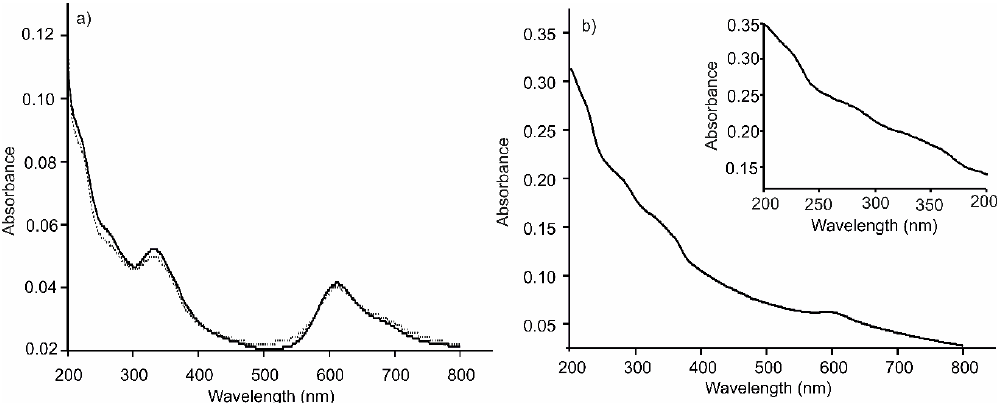
Figure 1. UV-Vis absorption spectra of LbL films of ( a ) [(CHI)-(CuPcS)-(CHI)-(AuNPs)] 2 (dotted line) and [(CHI)-(AuNPs)-(CHI)-(CuPcS)] 2 (solid line); ( b ) [(CHI)-(CuPcS)-(CHI)-(AuNPs)] 2 -Tyr. Inset shows a magnification of the band associated to the enzyme.